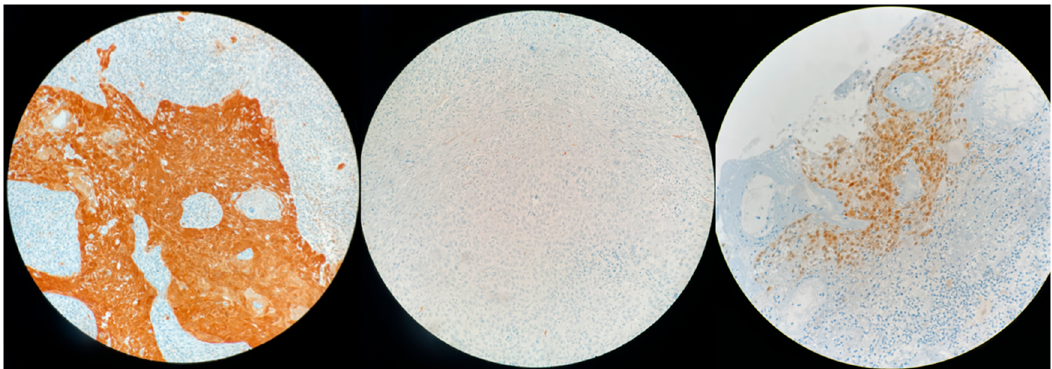
Figure 4. P16 expression on immunohistochemistry: positive ( left ); negative ( middle ); doubtful ( right